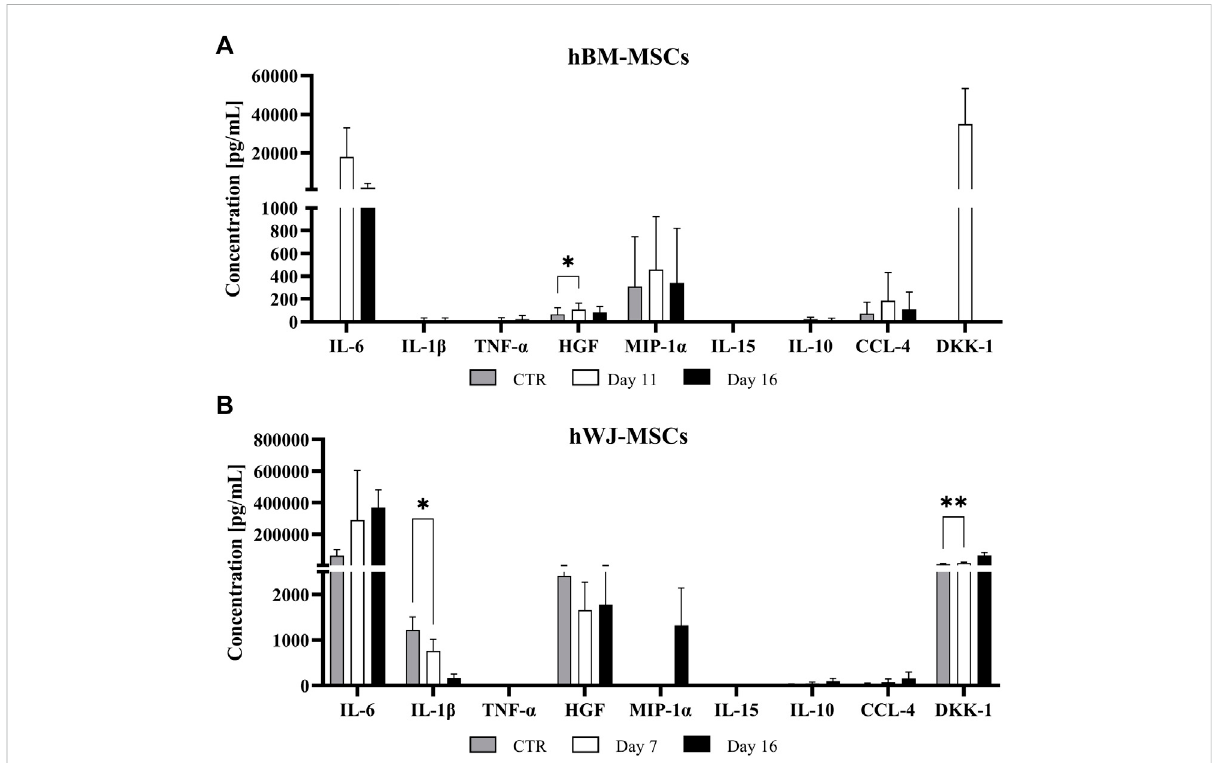
FIGURE 5 Cytokine release pro fi les of BM (A) and WJ (B) 3D culture in a chondrogenic medium supplemented with 10 ng/ml of TGF- β 1 for up to 16 days. Cytokine levels expresses as (pg/ml) were measured in the culture medium using a multiplex bead-based immunoassay at various time points and shown as means ± SD. * p < 0.05 and ** p < 0.01 ( N =